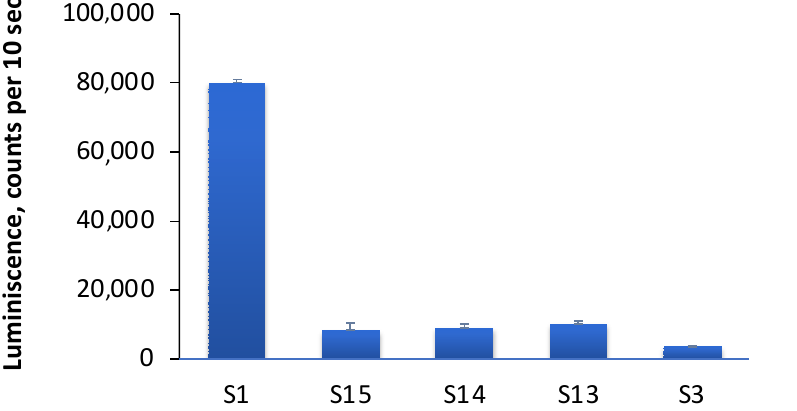
Figure 7. Transfection efficiency of HEK 293T cells with lipoplexes with various cationic lipids. Sample S1 contained 100% DOTAP, S3 contained 100% oleoylcholine, and samples S15–S13 contained a mixture of DOTAP and oleoylcholine in amounts of 11, 22, and 44%, respectively, of the total amount of cationic lipids (see LNP composition in Table 1). The untreated controls did not differ from the background signal (700 counts per 10 s). Incubation time was 24 h, n = 3.